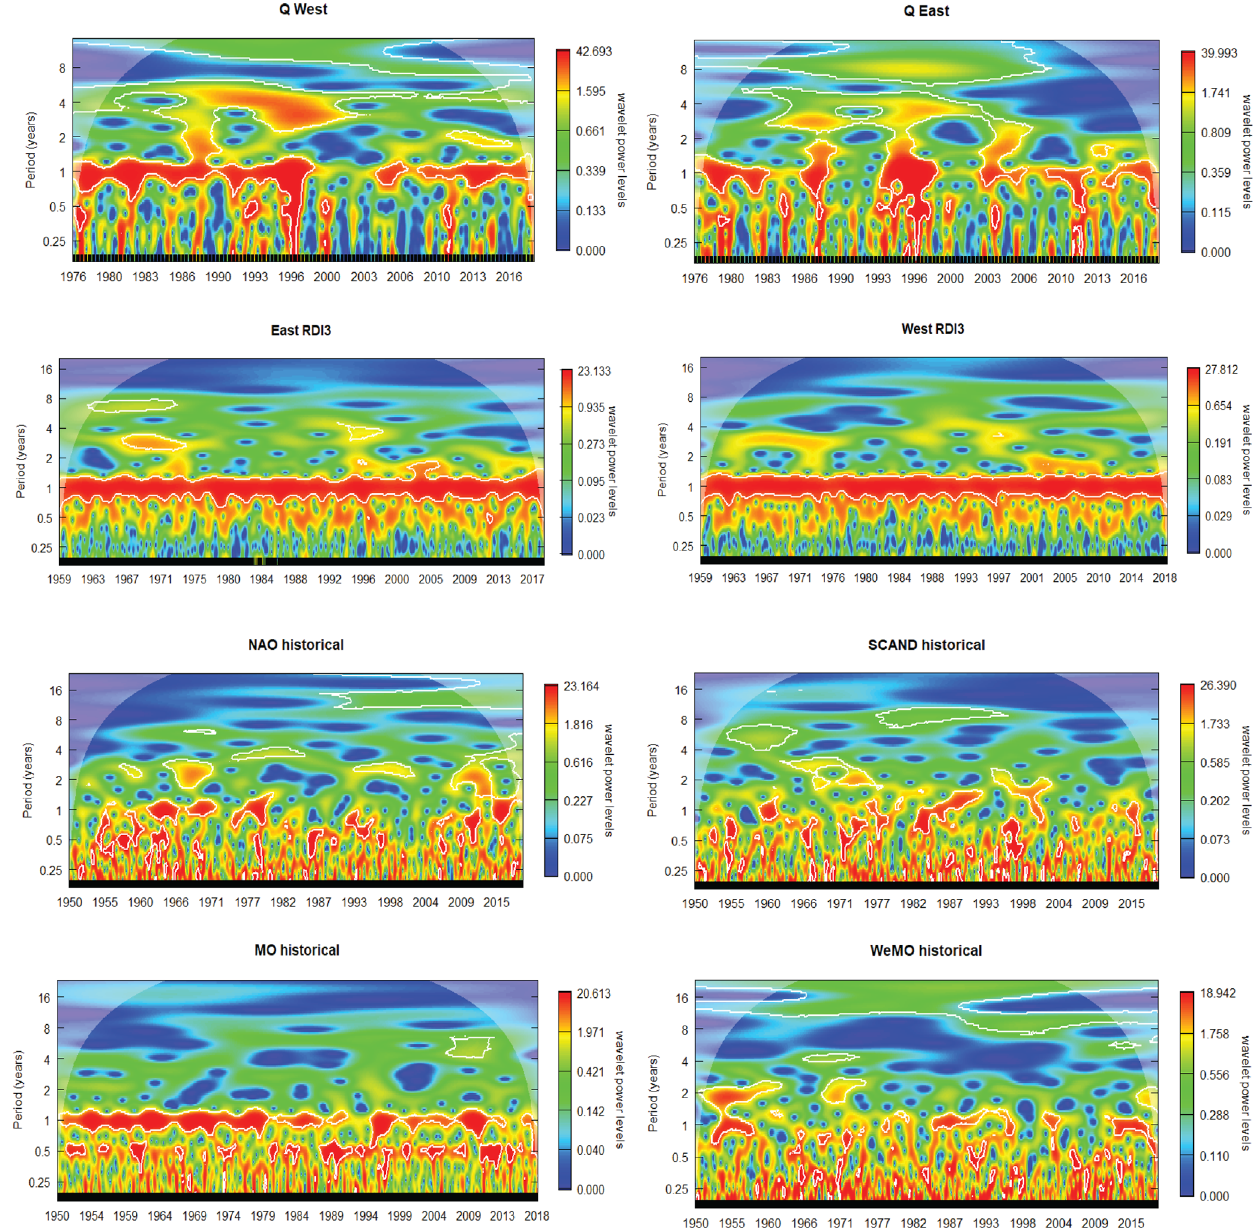
Figure 2. Continuous wavelet power spectra of the climate indices in the period 1950–2018 for TPs, 1959–2018 for RDI03, and 1976–2018 for Q